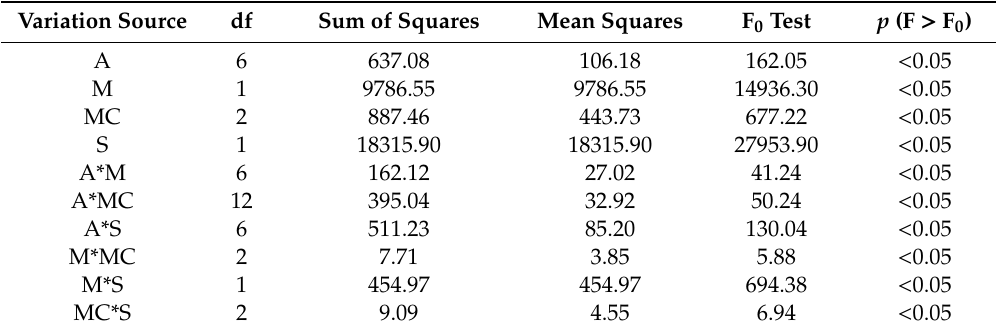
Table 2. Statistical analysis of the effect of variation source and its interactions on starch-based foams processing efficiency (E). Variation Source